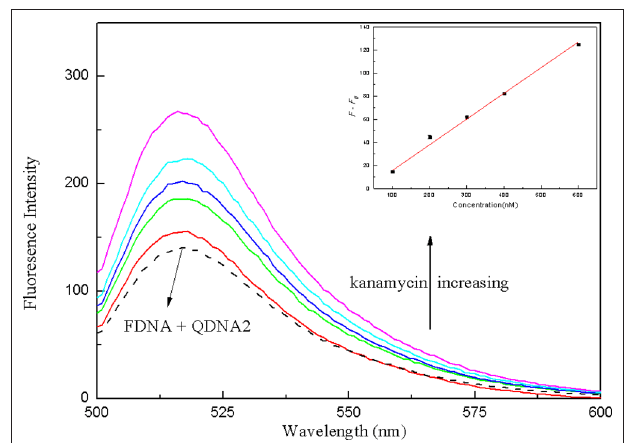
FIGURE 10 | The fluorescence spectra of the structure-switching aptamers for different concentrations of kanamycin spiked in milk samples. Inset: the linear calibration of fluorescence recovery ( F–F 0 ) vs. kanamycin concentration in milk samples. The concentration of FDNA was 0.05 µ M, QDNA2 was 0.1 µ M, and kanamycin was 100, 200, 300, 400, 600nM, respectively.